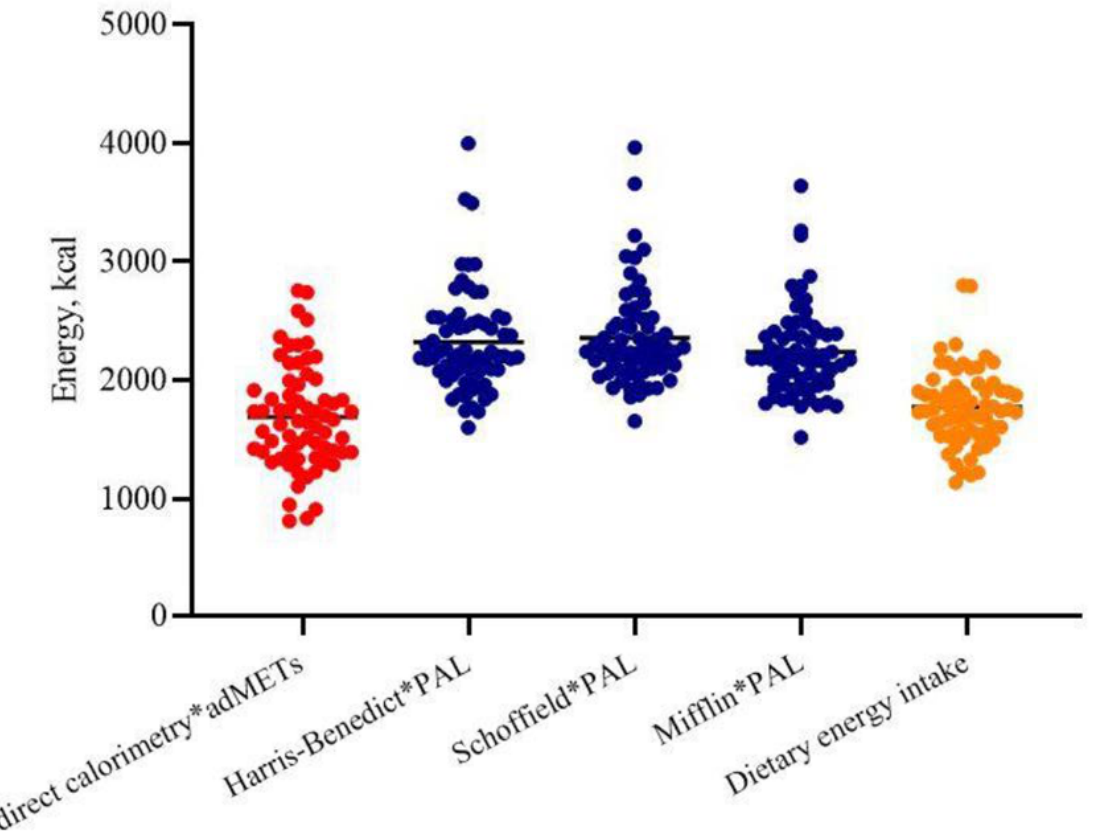
Figure 1. Total energy expenditure measured by indirect calorimetry *adMETs (red points) and estimated by predictive equations *PAL (blue points). The ANOVA ( p = 0.0001). The yellow points represents dietary energy intake derived from dietary recalls.